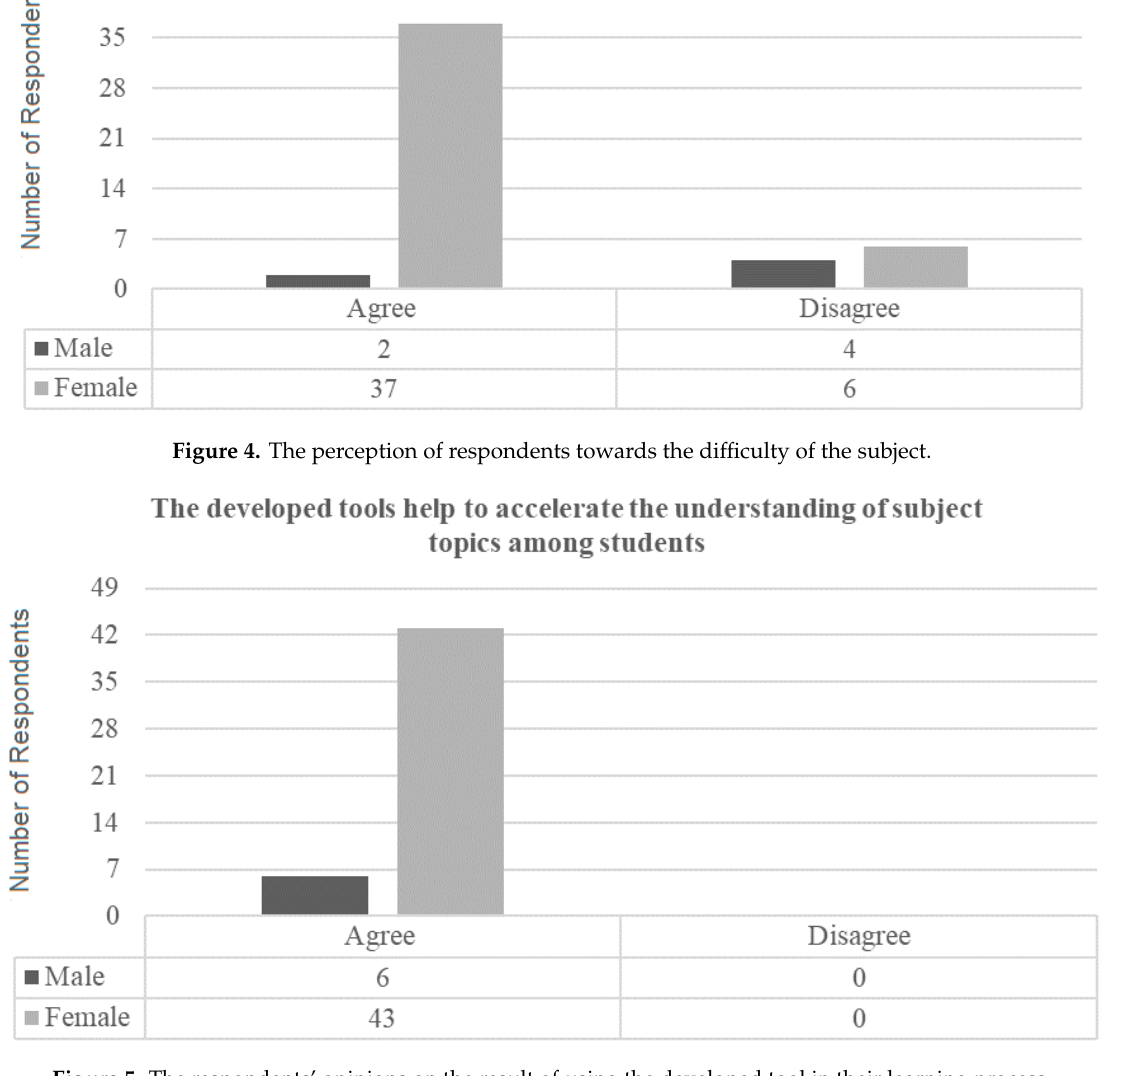
Figure 5. The respondents’ opinions on the result of using the developed tool in their learning process.